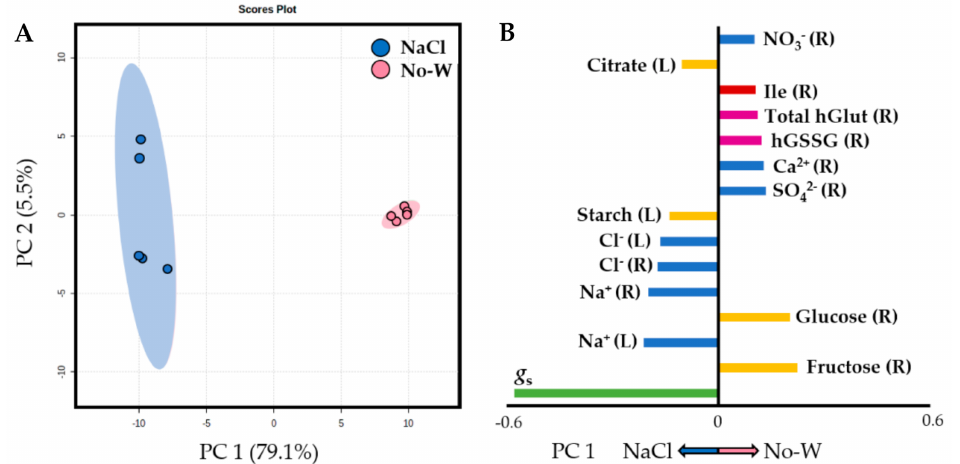
Figure 3. Principal Component Analysis conducted with all measured parameters in NaCl and No-W treated plants. ( A ) PCA plot showing the NaCl and non-irrigated (No-W) cases. ( B ) Loading values of all variables in PC1 separating both treatments. g s , stomatal conductance; hGlut, homoglutathione; hGSSG, oxidized homoglutathione; L, leaves; R, roots. Bar key: green, physiological measurements; yellow, carbohydrates; blue, inorganic ions; pink, antioxidants; red, amino